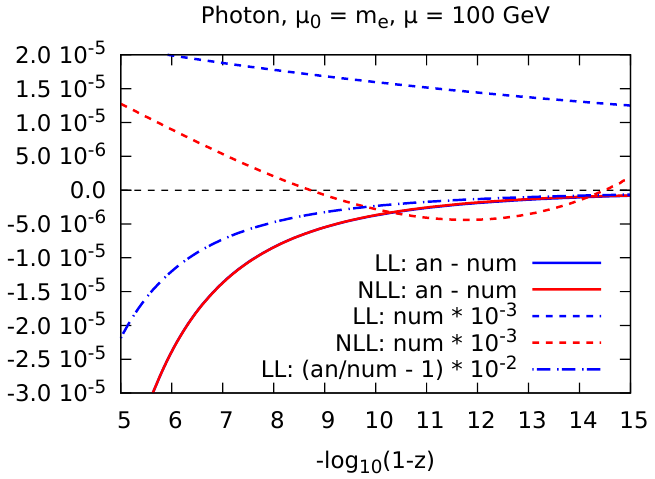
Figure 12 . Behaviour of the photon PDF at very large z values, where the analytical and numerical predictions are compared. We have set (cid:22) = 100